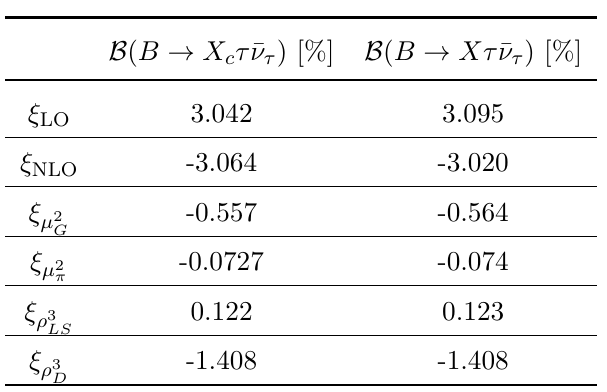
Table 3 . Predictions for the branching ratio within the local OPE, using V cb = (42 . 16 ± 0 . 51) · 10 − 3 [1] and split according to (3.1). We quote the flavour-averaged rate. Predictions for the charged or neutral B decay can be obtained by multiplying with τ